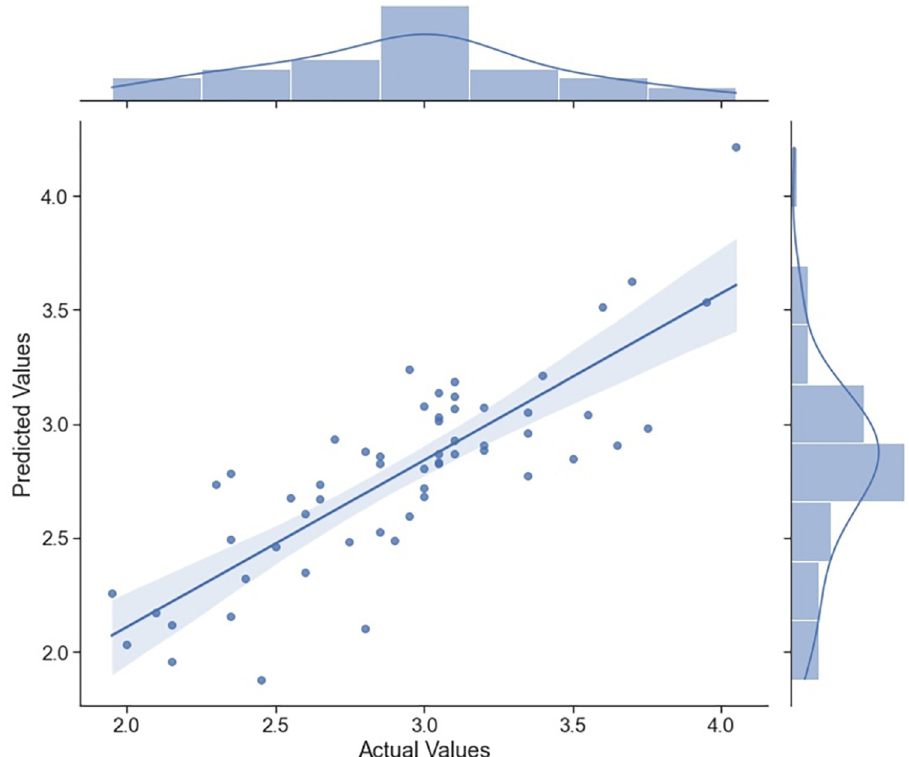
Fig 5. Correlation of the predicted values of the attention-based LSTM model and the actual values. The data presented in this figure are all time series data in the same time interval, which is, the time interval we used for model testing from 49 th week of 2020 (November 30 th to December 6 th ) to the 52th week of 2021. The abscissa of this scatter plot in the main figure is the actual ILI values and the ordinate of this chart is the predicted values of our proposed ATLSTM model. The regression line of those scatter points is also given in the main figure, where the shadow around the line represents the confidence interval. The two auxiliary figures on the top and on the right are the distribution plots of actual values and predicted values respectively. As a supplement to the known results that R-square of our proposed ATLSTM model is 0.752, in this line figure, we can also find a high degree of correlation between predicted values and actual values, which show the ATLSTM model can return a good